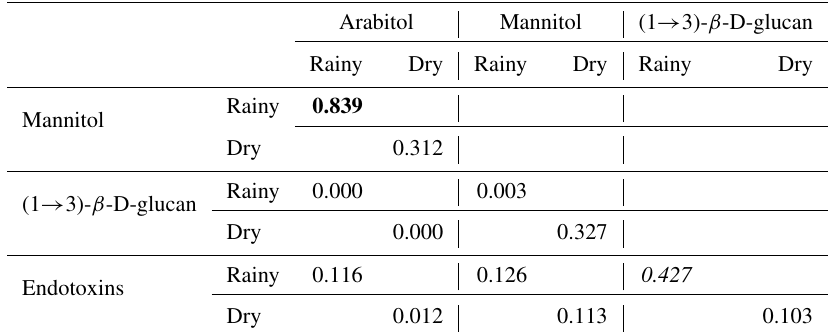
Table 2. Square of correlation coefficients ( R 2 ) comparing total mass concentration of molecular tracers to each other. EU: endotoxin units. Boxes colored by coefficient value ( bold >0.7; 0.7 > italic